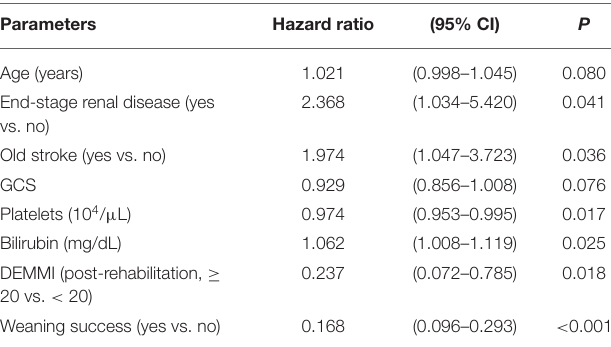
TABLE 5 | Multivariate Cox regression models for significant clinical characteristics associated with overall survival after respiratory failure * .